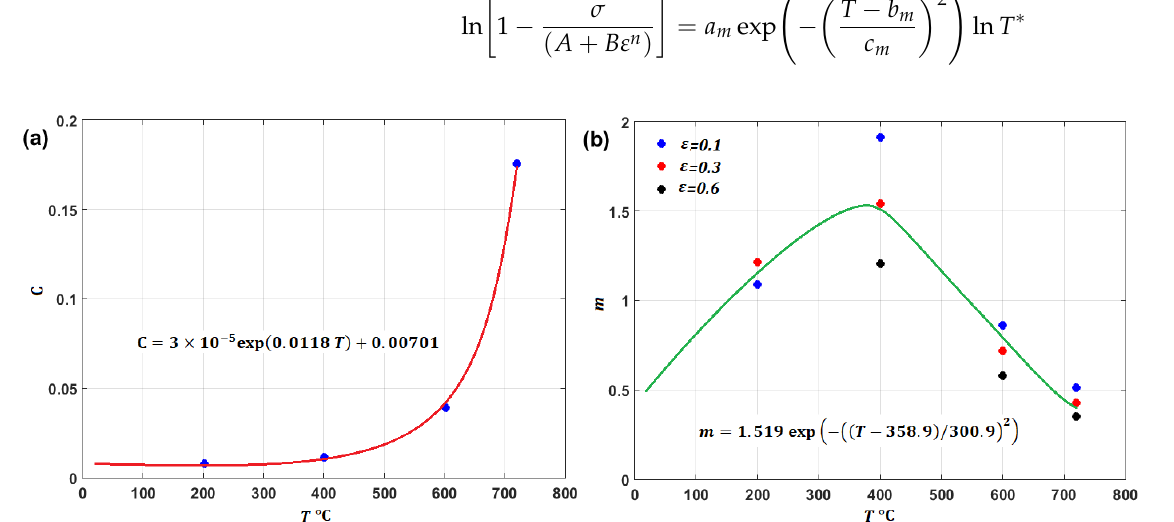
Figure 52. ( a ) Exponential fitting of strain rate parameter vs. temperature; ( b ) gaussian fitting of softening parameter vs. temperature.